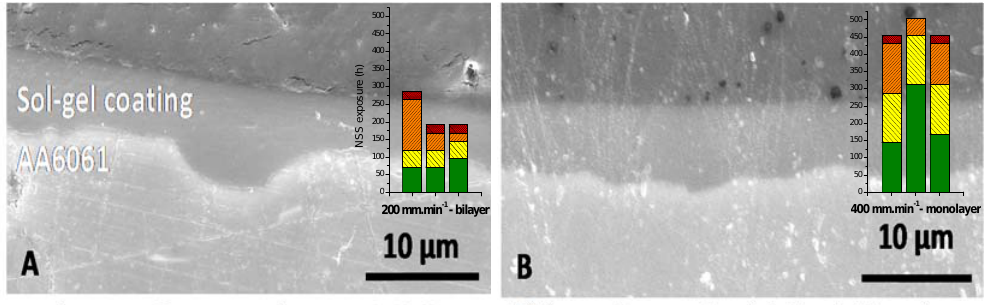
Figure 12. Comparison between (A) bilayer and (B) monolayer system (similar thickness).